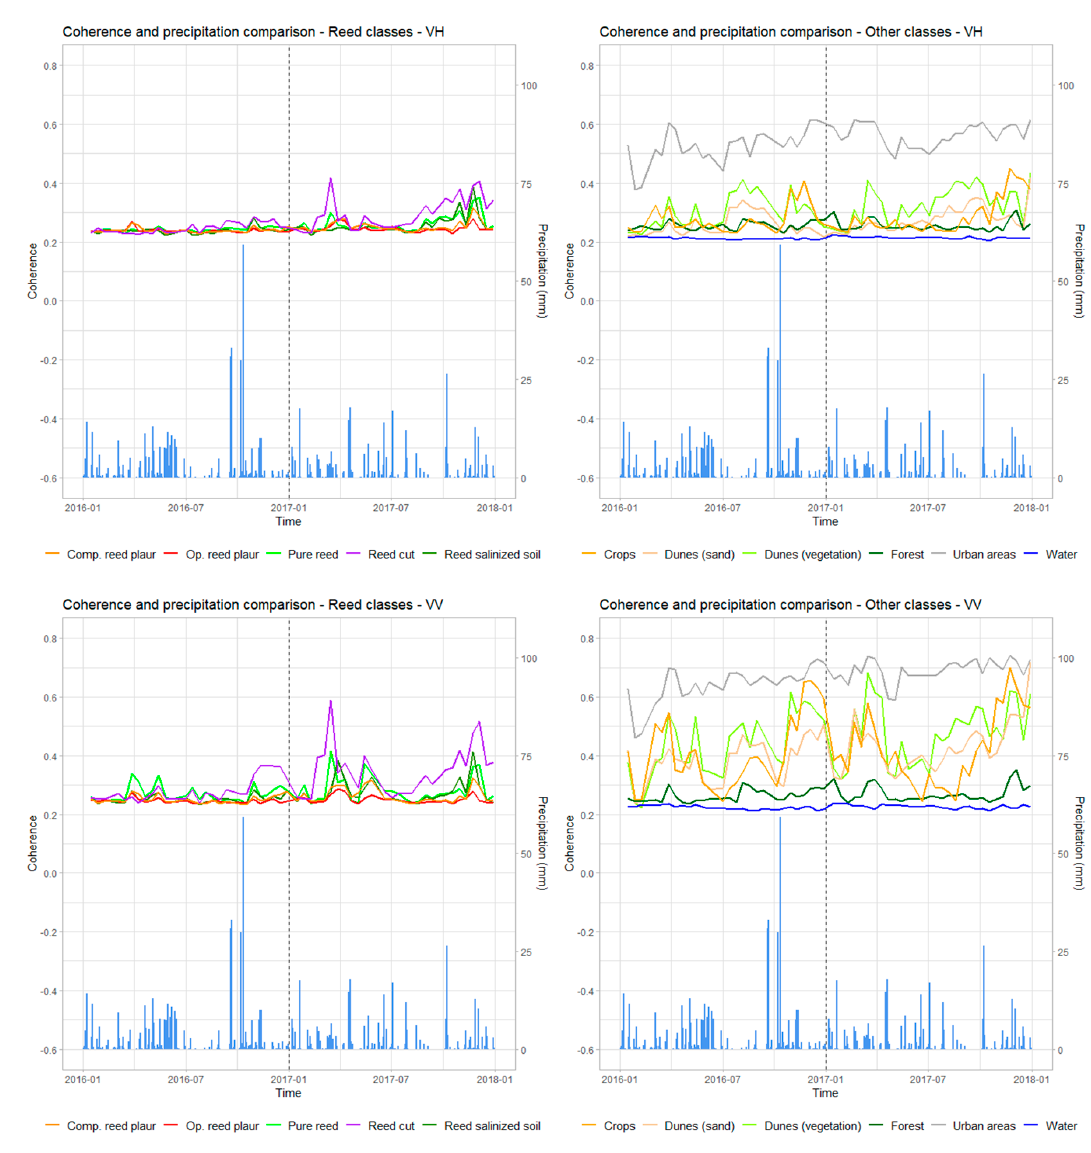
Figure 7. Comparisons of the time series of coherence mean for the different classes of Phragmites australis + other classes of land cover and precipitation, over the period 2016–2017. Polarization VH and VV.